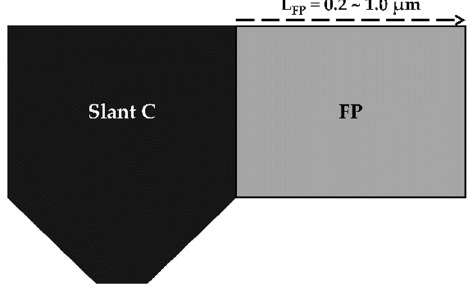
Figure 11. Schematic of the slant C with a drain-side extended field-plate (FP) applied gate struc- ture.